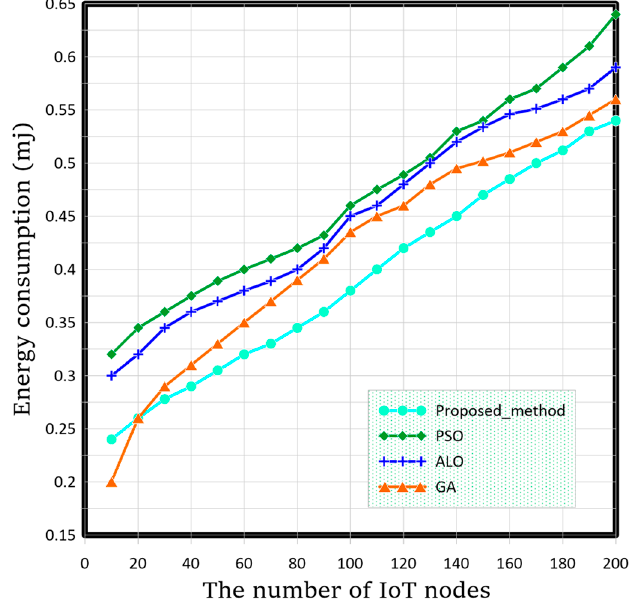
Figure 6. Comparison of the suggested method’s energy consumption with that of the PSO, ALO, and GA algorithms.